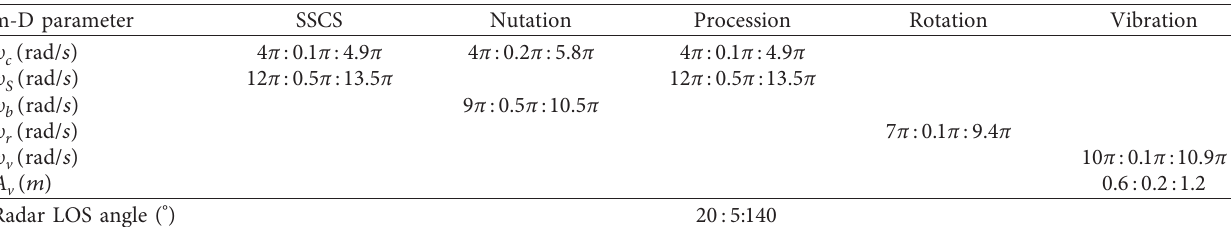
Figure 6: The time-frequency spectrograms of the five targets: (a) procession streamlined structure warhead; (b) nutation; (c) procession; (d) rotation; (e) vibration. Table 1: Target m-D parameter settings.